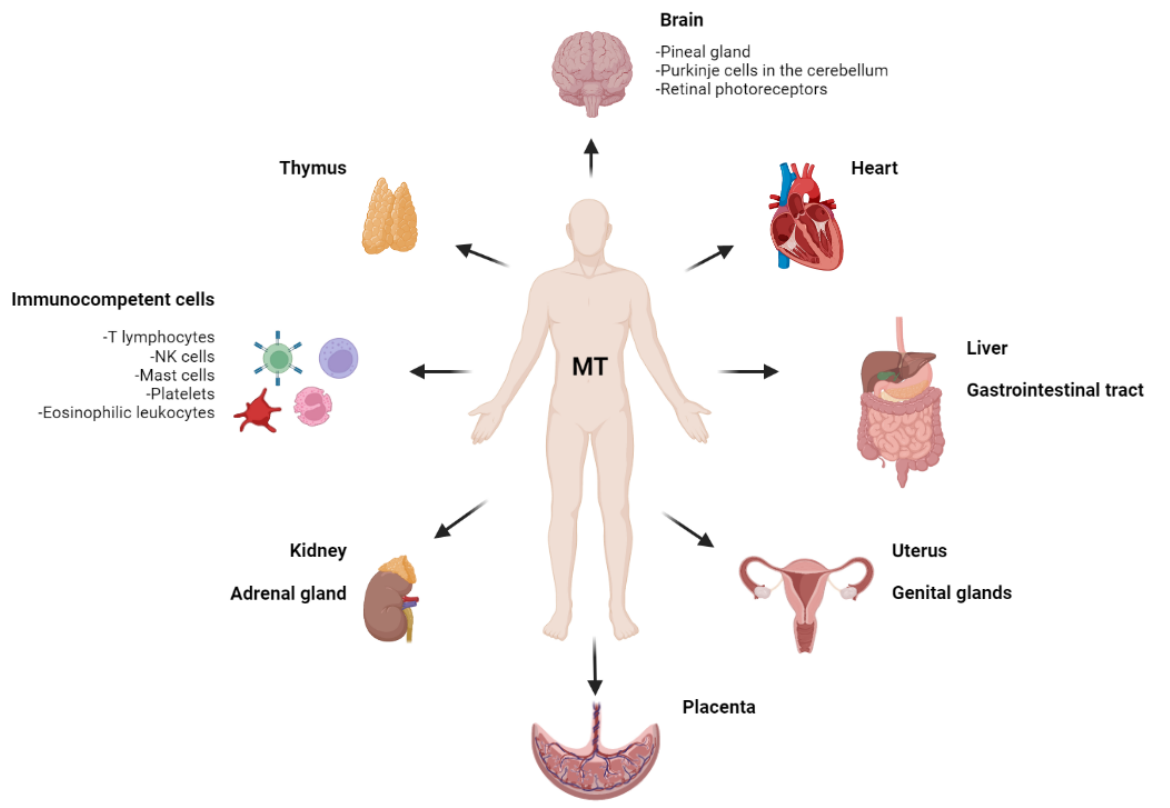
Figure 1. Melatonin localization in the human body. The figure illustrates the unique property of melatonin to have the most widespread localization in the human body, being synthesized in vari- ous organs. various